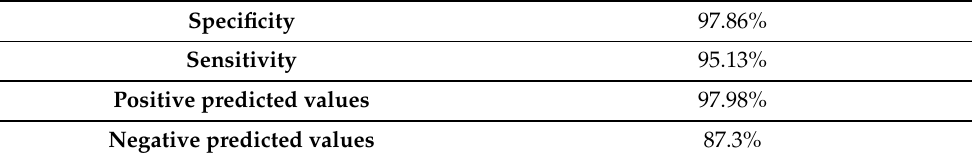
Table 3. Training